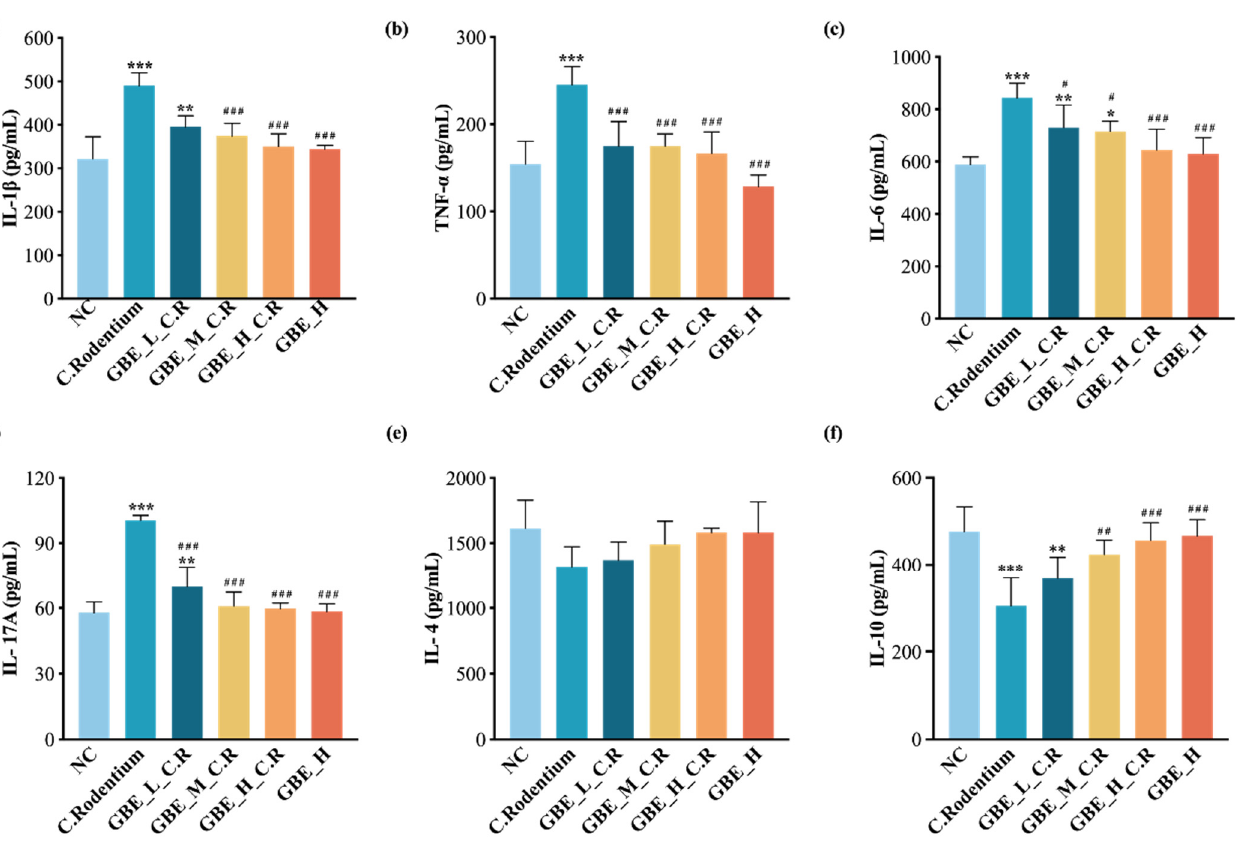
Figure 4. GBE suppressed the pro-inflammatory factors IL-1 β ( a ), TNF- α ( b ), IL-6 ( c ), and IL-17A ( d ), whereas it increased the anti-inflammatory factors IL-4 ( e ) and IL-10 ( f ) in the mice. All the in fl ammatory factor contents were determined using the ELISA kits. *** p < 0.001, ** p < 0.01, and * p < 0.05 vs. NC group; ### p < 0.001, ## p < 0.01, and # p < 0.05 vs. C. Rodentium group.